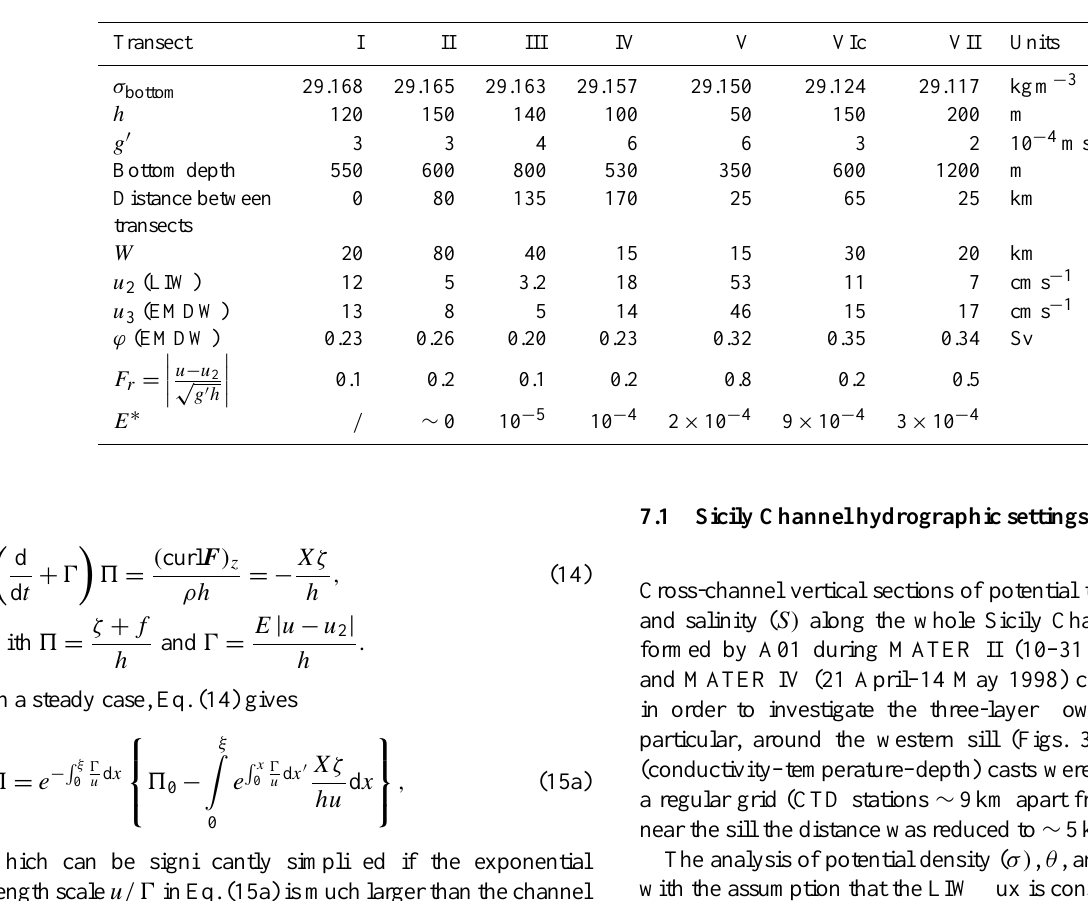
Table 1. Main experimental quantities measured by A01 in the Sicily Channel and in the southern Tyrrhenian Sea during the MATER II cruise (Figs. 1 and 3). Here σ bottom is the maximum σ θ observed in the hydrographic casts; h is the bottom-layer thickness; g (cid:48) the reduced gravity; ϕ (EMDW) is the EMDW volume transport; the Froude number is Fr ; the entrainment parameter E ∗ is the one computed by Baringer and Price (1997b). ∗ LIW and EMDW velocities for section III were obtained from current-meter measurements. Velocities for the sections were obtained by using continuity, considering the total transport and dividing by the cross sectional